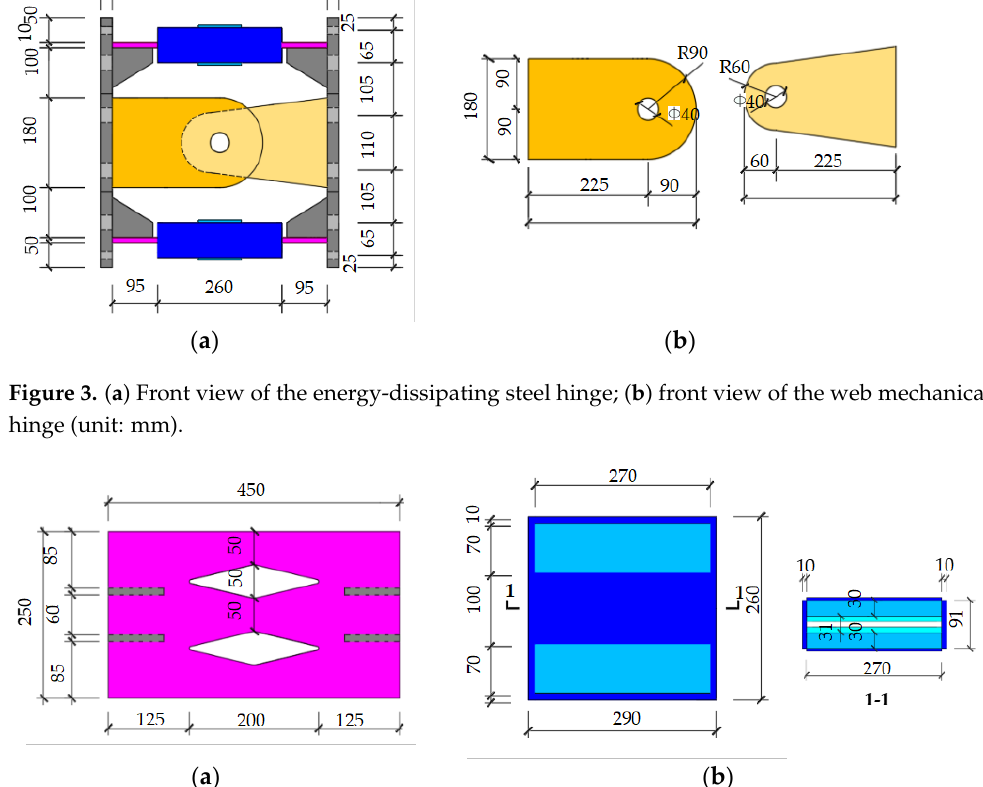
Figure 4. ( a ) The reduced energy-dissipation steel plate with diamond-shaped holes; ( b ) buckling constraint sleeve construction (unit: mm).